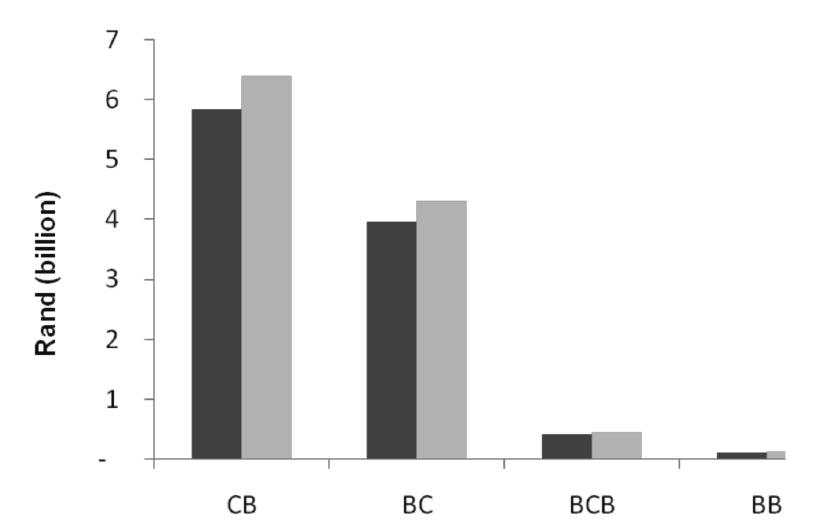
Figure 3: Road transport cost increases per flow type if axle limit change is implemented (data source: FDM, 2009, and CSCM Cost Model,